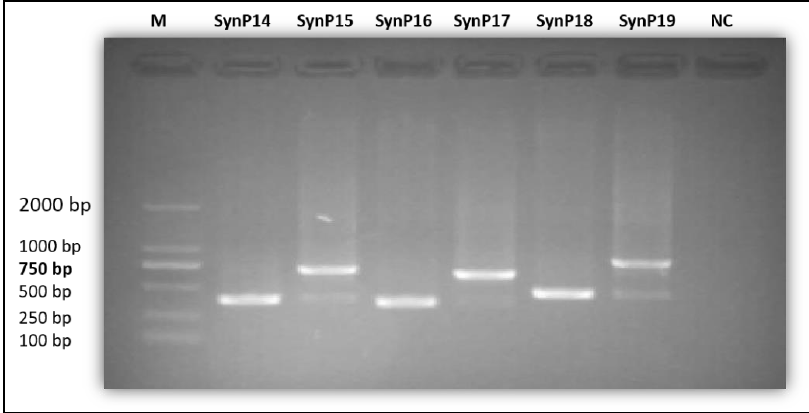
Figure 5. PCR verification of K599 transformants. M is 2 kb Marker and NC is negative control.